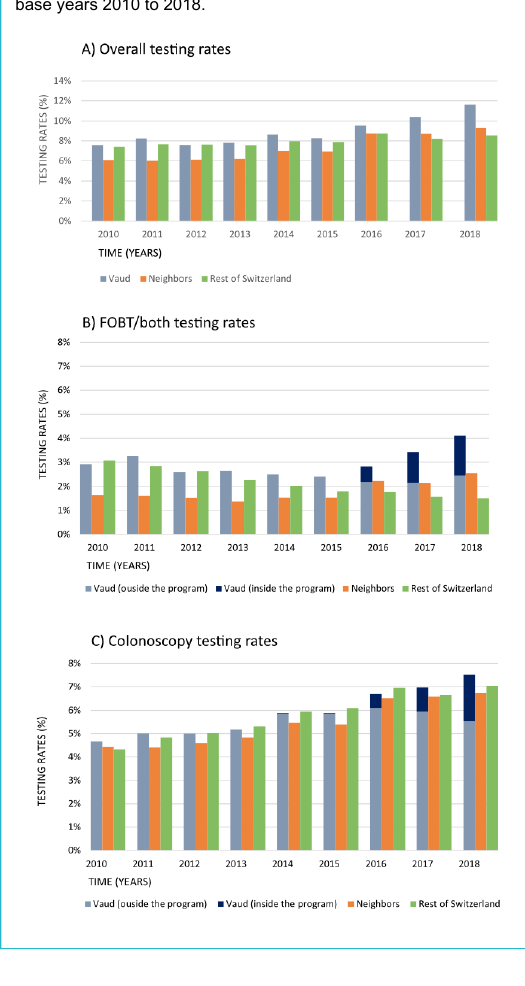
Figure S2: Change in colorectal cancer testing (% of insures test- ed each year) presented as: A) overall testing rates (any test for colorectal cancer), B) faecal occult blood test; and C) colonoscopy in those aged 50–69 in Vaud, neighbouring cantons and the rest of Switzerland, between 2010 and 2018. The organized screening program for colorectal cancer began in 2015 in Vaud. CSS data- base years 2010 to 2018.